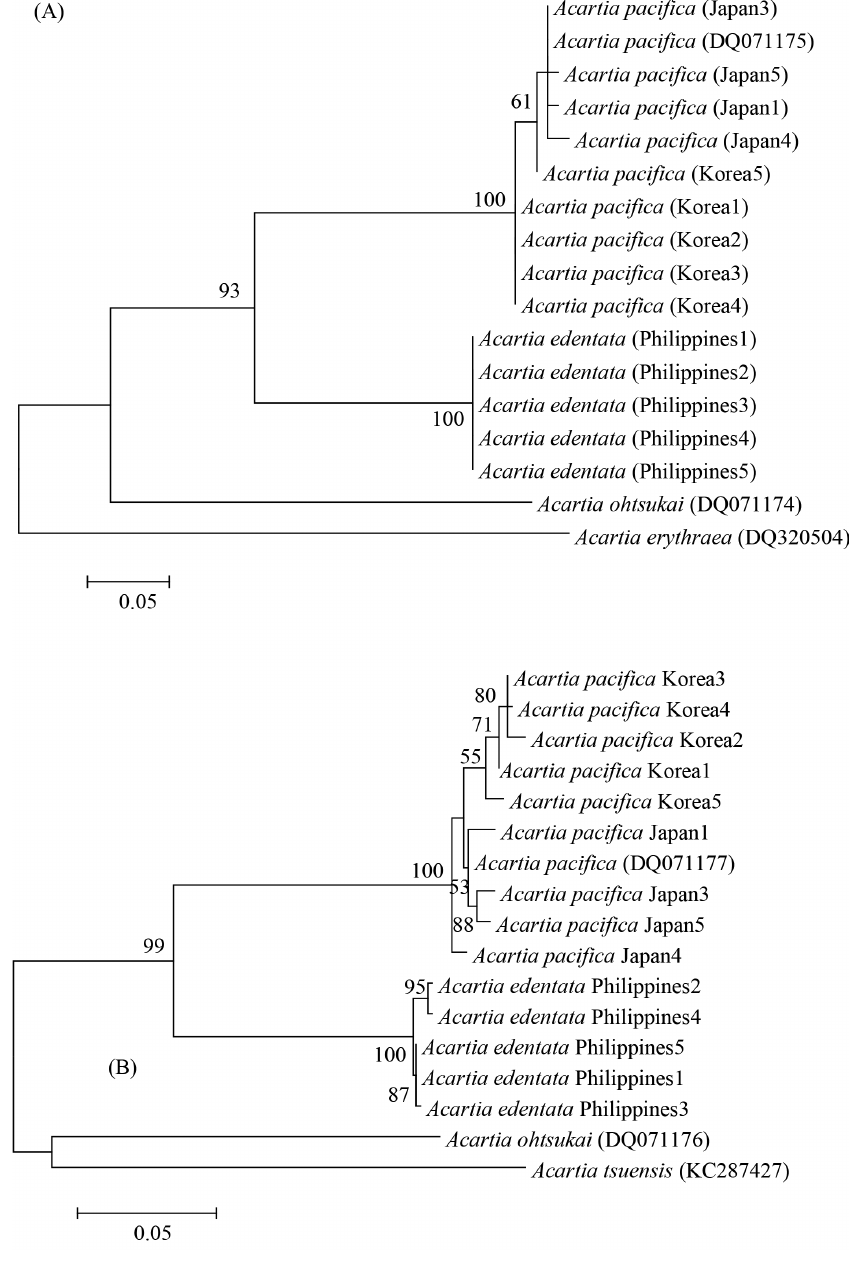
Figure 6. Neighbor-joining phylogenetic tree based on the mitochondrial 16S ( A ) and COI ( B ) genes of Acartia ( Odontacartia ) edentata sp. n., and A. ( O. ) pacifica from Ariake Bay in the Seto Inland Sea and Korean waters. A. ( O. ) erythraea , A. ( O. ) ohtsukai and A. ( O. ) tseuensis sequences from GenBank were used as outgroups. Bootstrap values (percentage) are shown for nodes with support > 50%. Supporting valves of each node obtained from 1,000 bootstrap